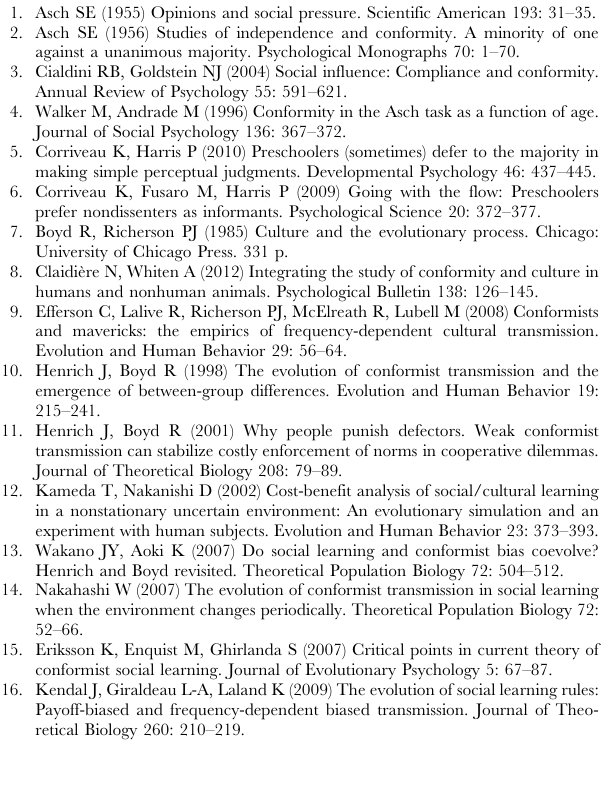
Table S2 Data for the study regarding conformity at the individual level. Card: the card number. Gender: male (0) or female (1). Age class: 4 classes: 0–5 (0), 6–10 (1), 11–16 (2) and 17